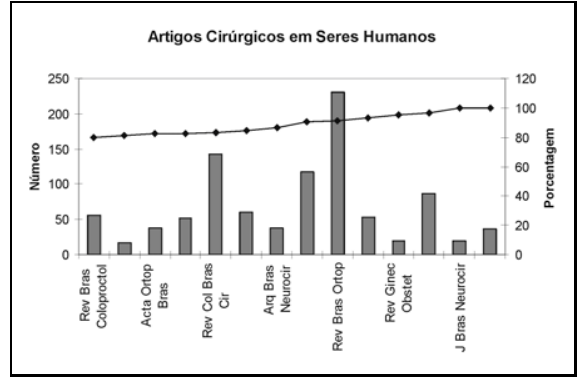
FIGURA 2 (cid:150) GrÆfico que mostra a porcentagem crescente dos artigos cirœrgicos originais, segundo o aspecto de estudo em seres